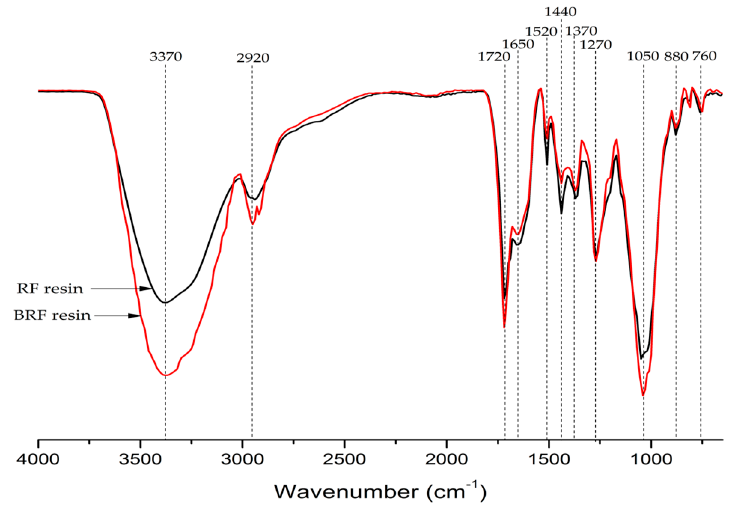
Figure 3. FTIR spectrum of 20%-BRF and RF resins.